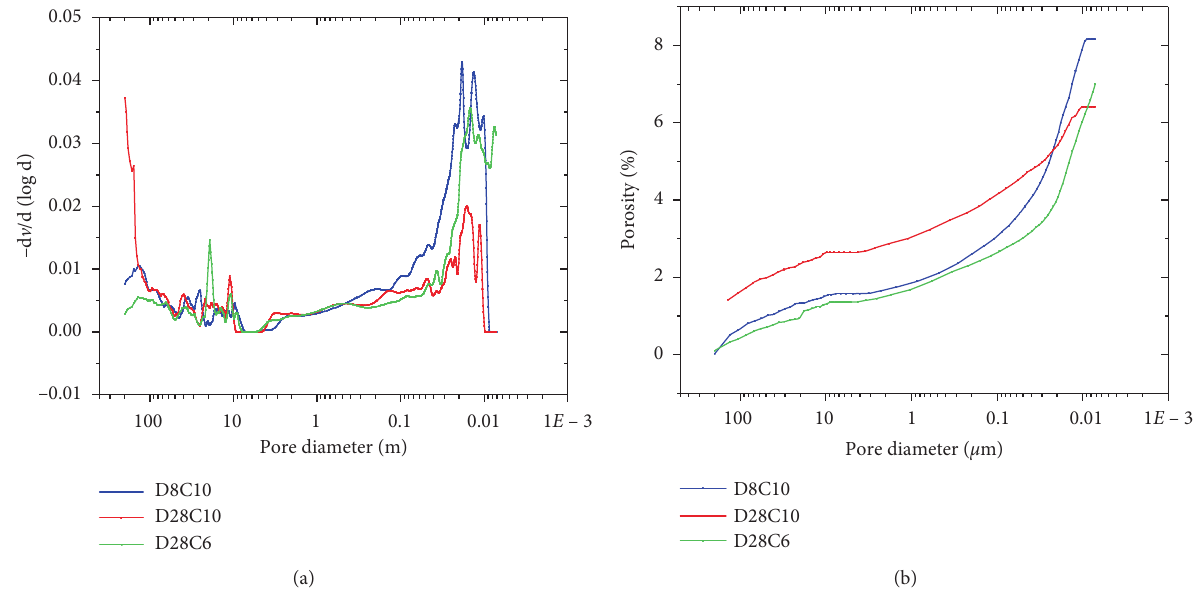
Figure 13: Pore size distribution of specimens with different crack widths and salt-freezing cycles: (a) most probable pore radius and (b)